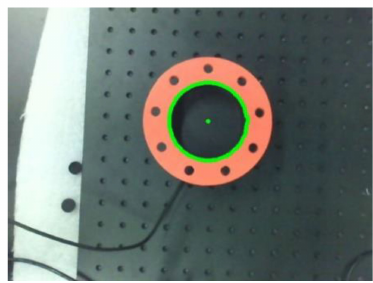
Figure 6. The extraction results of contour and center coordinates.